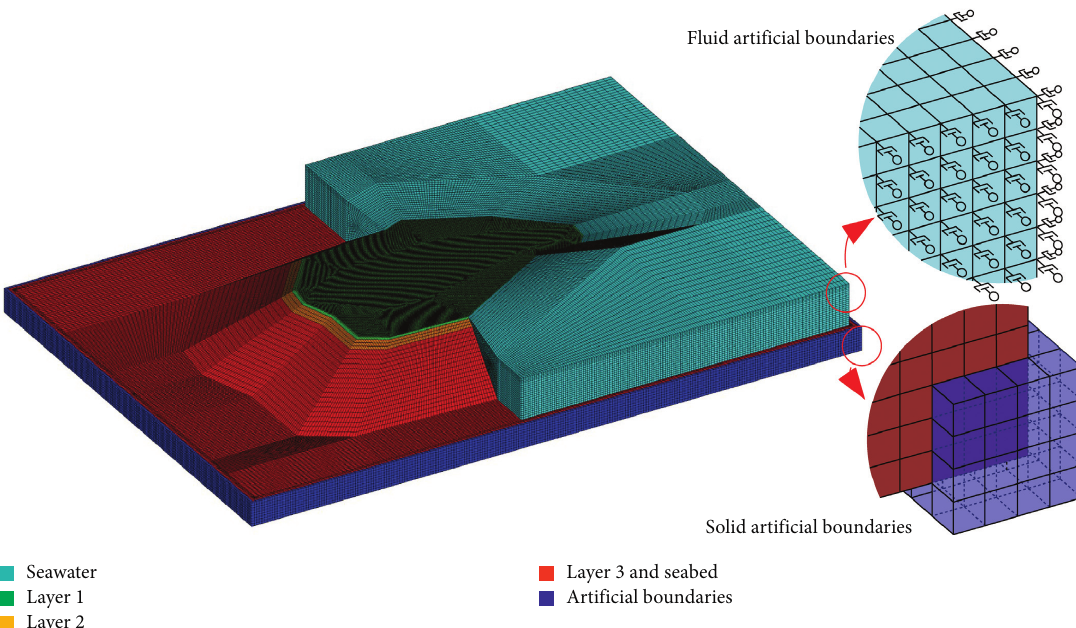
Figure 3: 3D finite element model of Zhubi